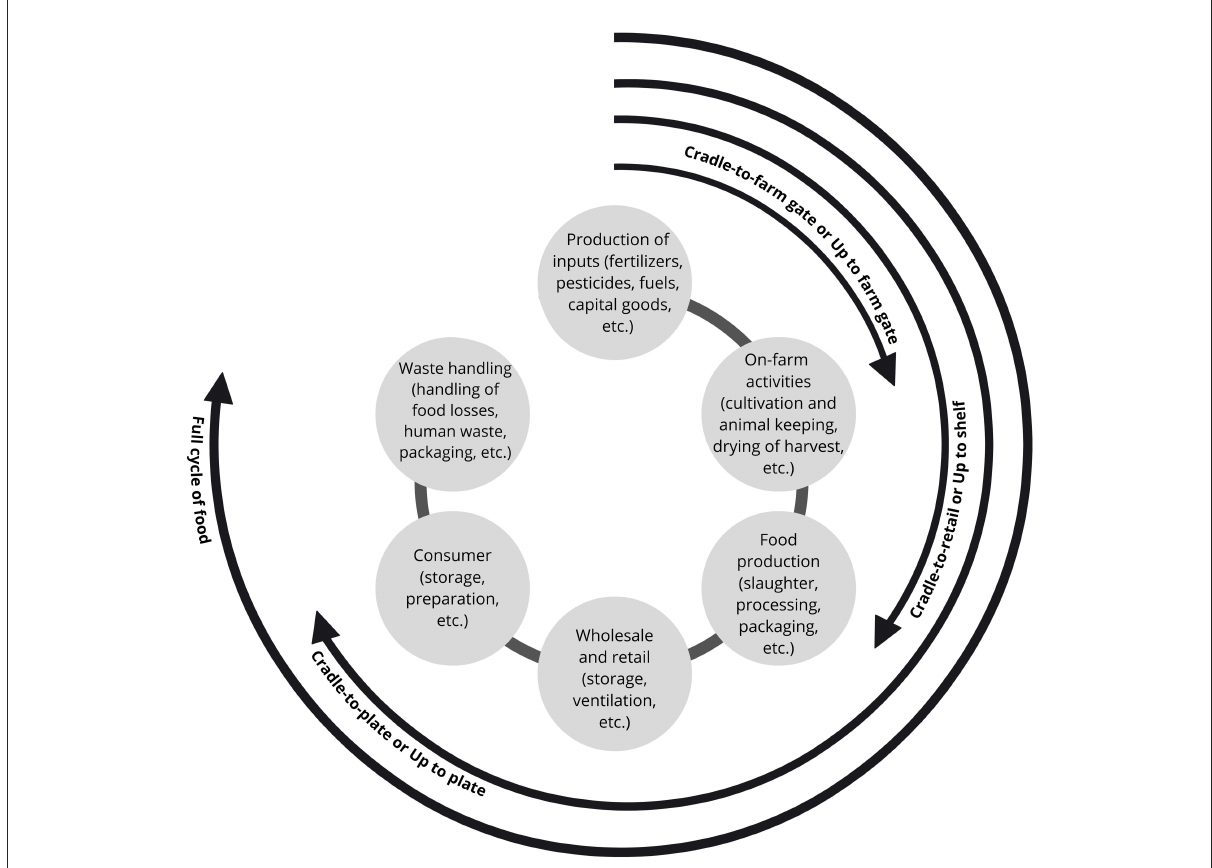
FIGURE5 System boundaries classifications for food environmental footprint analysis considering the food life cycle (Pandey and Agrawal, 2014; Röös et al., 2014).